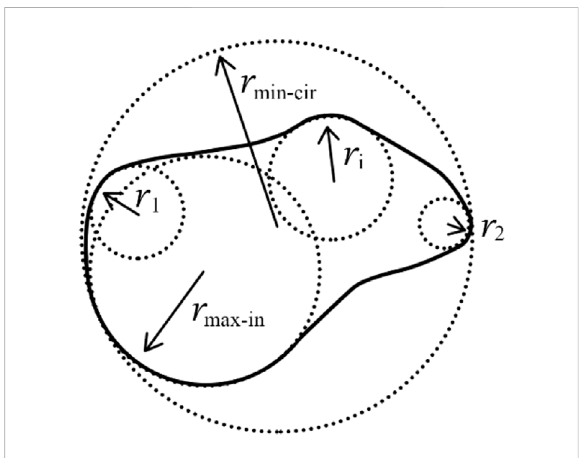
FIGURE 3 Illustration of particle shape